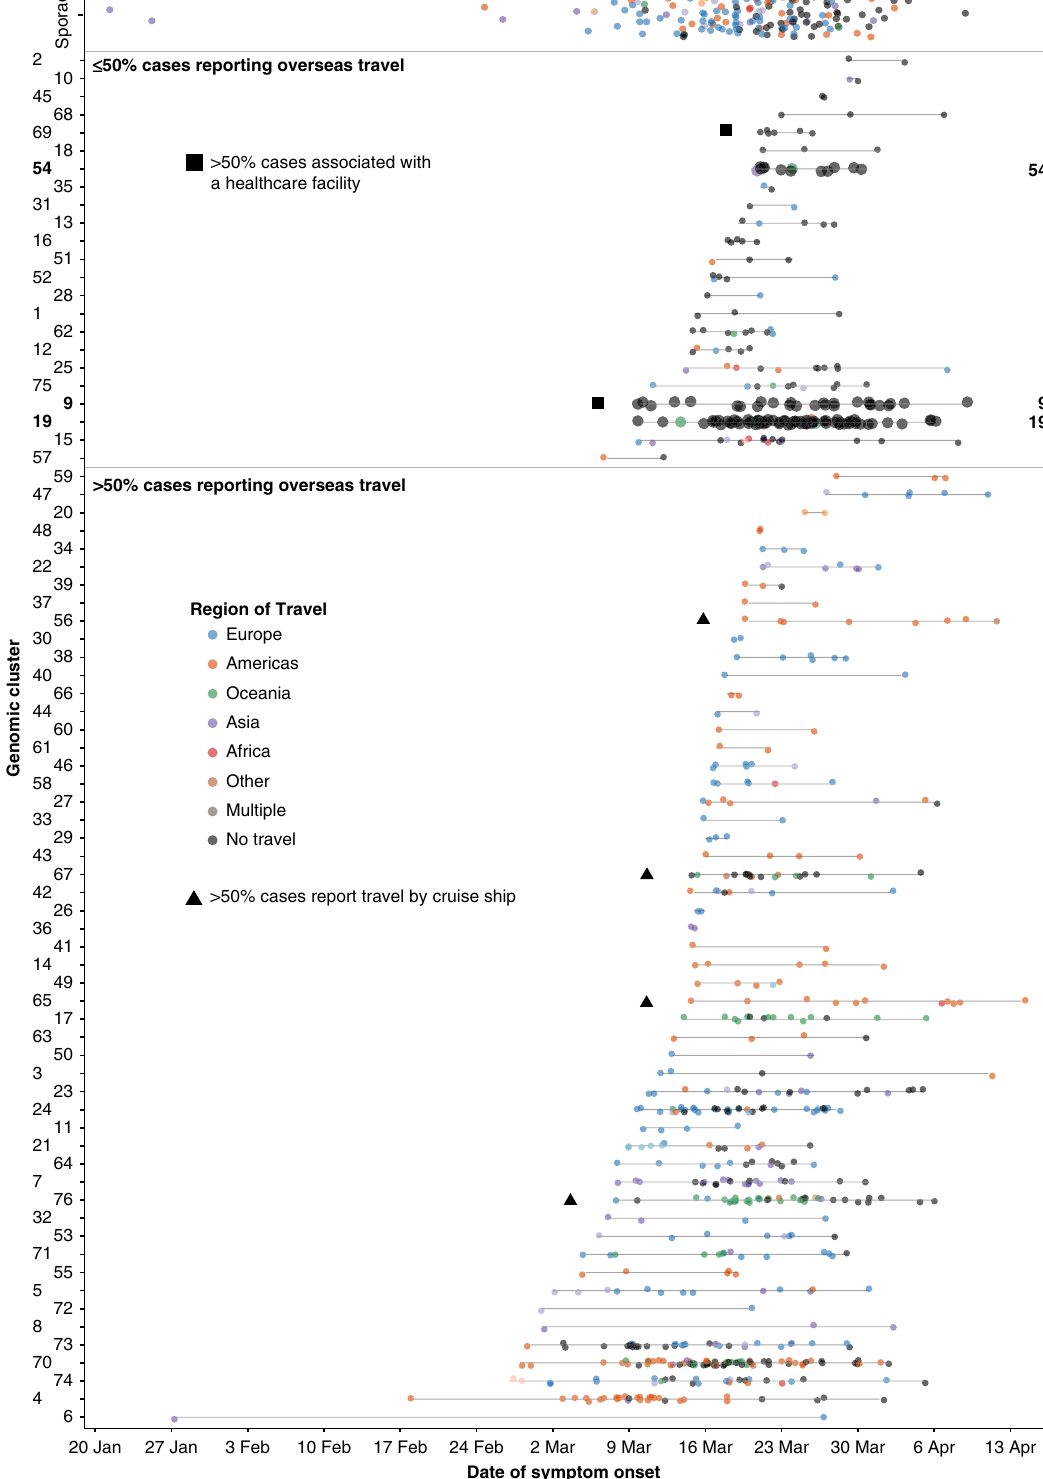
Fig. 4 Timeline and key epidemiological features of Victorian severe acute respiratory syndrome coronavirus 2 (SARS-CoV-2) genomic clusters. Each case in a genomic cluster is represented by a dot, colored by location of travel. Cases are plotted by onset date on the X axis, and genomic cluster on the Y axis. Genomic clusters discussed in the text are enlarged and marked with their cluster number to the